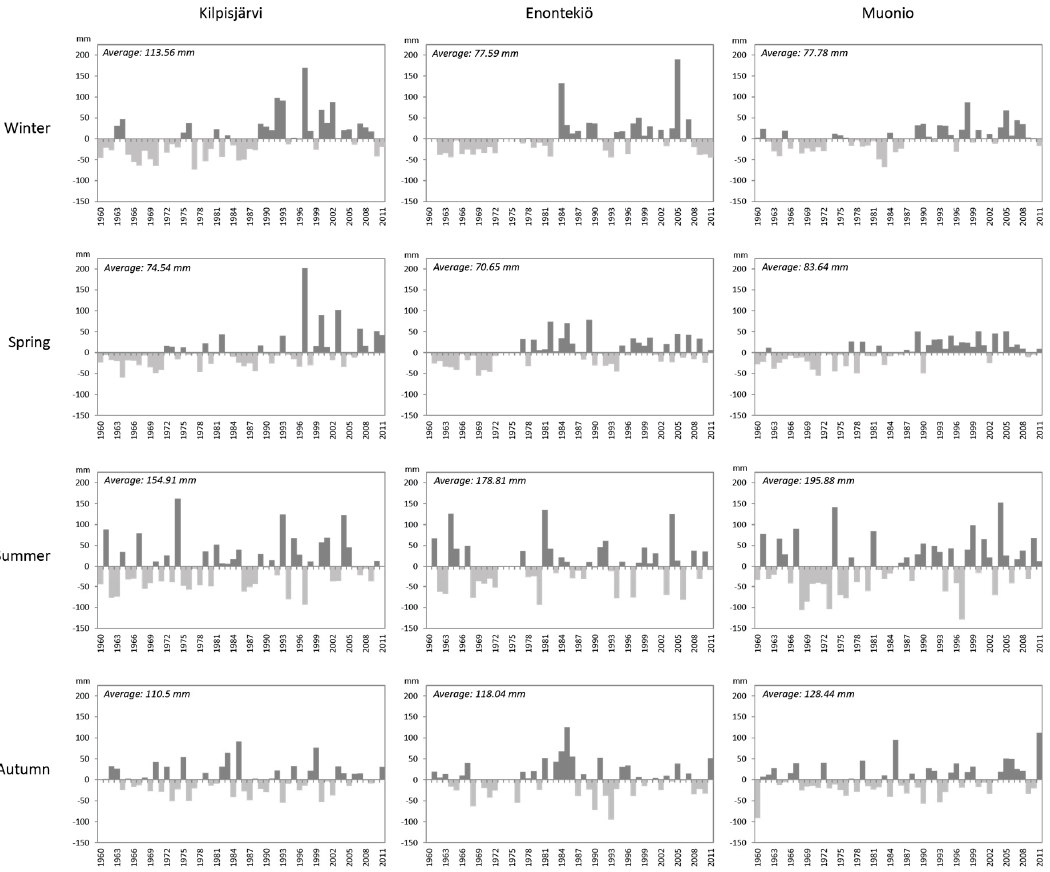
Figure 6. Annual anomaly of seasonal precipitation (mm) at Kilpisjärvi, Enontekiö and Muonio, 1960–